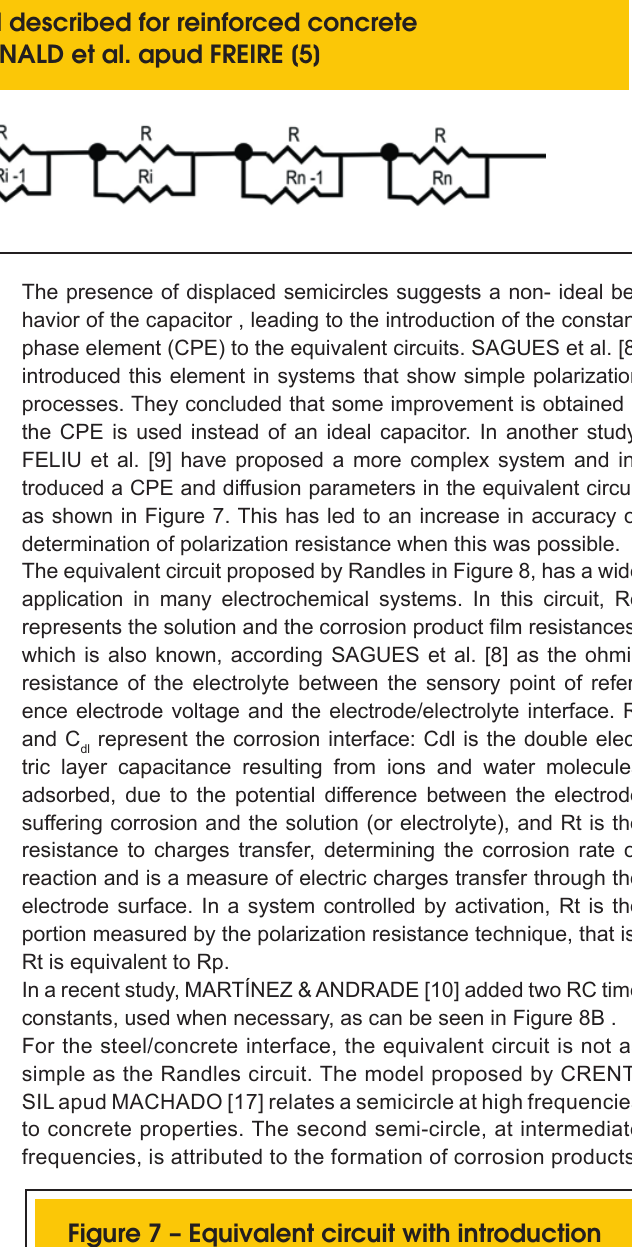
Figure 7 – Equivalent circuit with introduction of CPE, proposed by FELIU et al. [9]. Re = electrolyte resistance; Rf = charge transfer resistance; CPE = constant phase element; ZD = Warburg